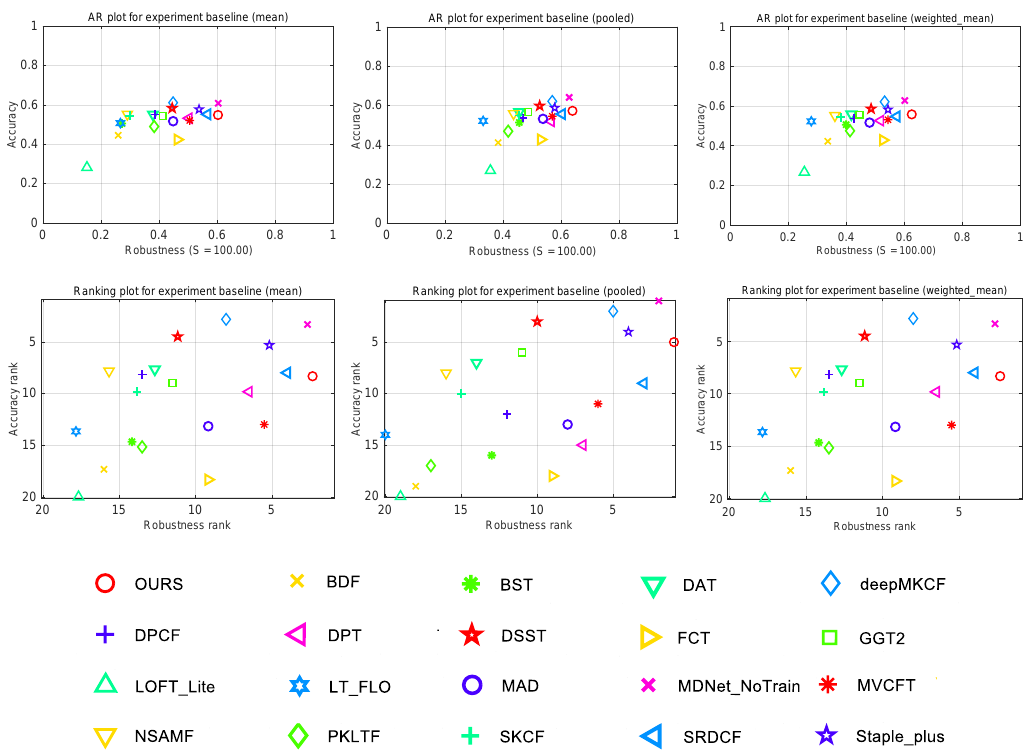
Figure 6. The overall AR raw plots and the AR rank plots of the 20 compared trackers on VOT-TIR2016.